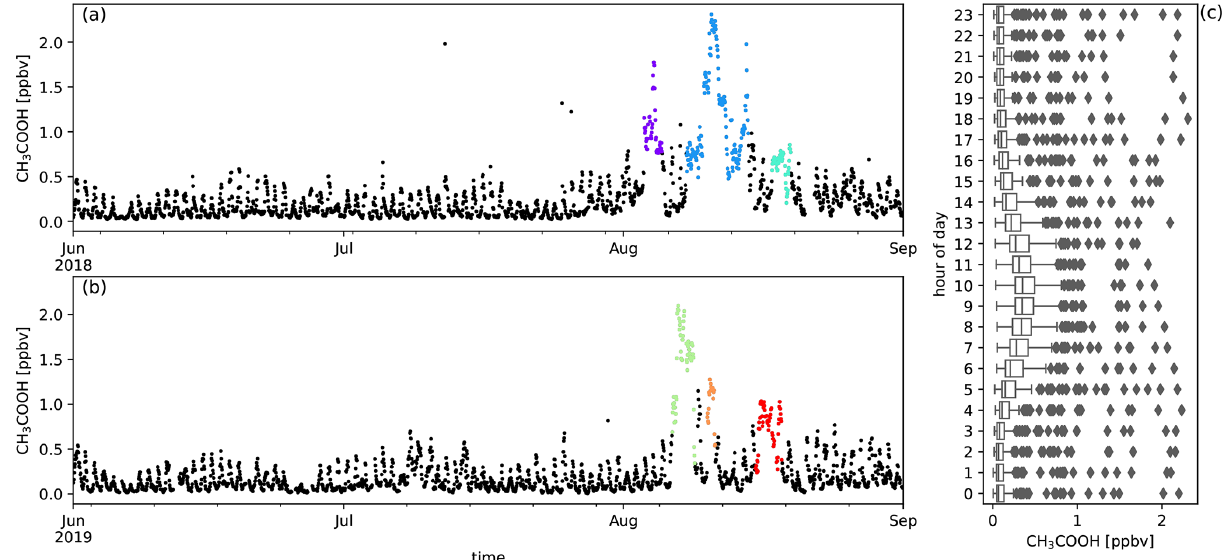
Figure A6. Measured CH 3 COOH mixing ratios (ppbv) during austral winter 2018 (a) and austral winter 2019 (b) together with the diel distribution of hourly averages (c) . Biomass burning plumes under investigation are highlighted in colours.